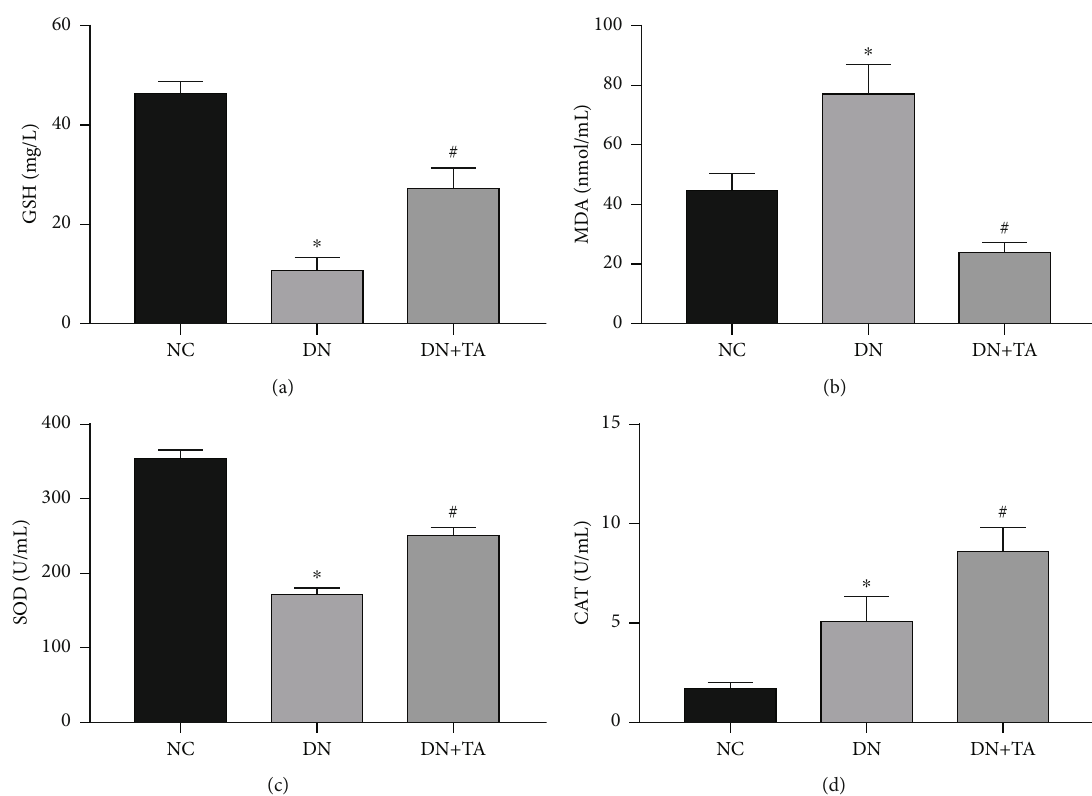
Figure 3: TA mitigated oxidative stress in DN. The decreased GSH (a) content, SOD (c), CAT (d) activities, and increased MDA (b) content were remarkably reversed by TA treatment. Data were expressed as mean ± SD ( n = 10 ). ∗ P < 0 : 05 versus NC group; # P < 0 : 05 versus DN group.